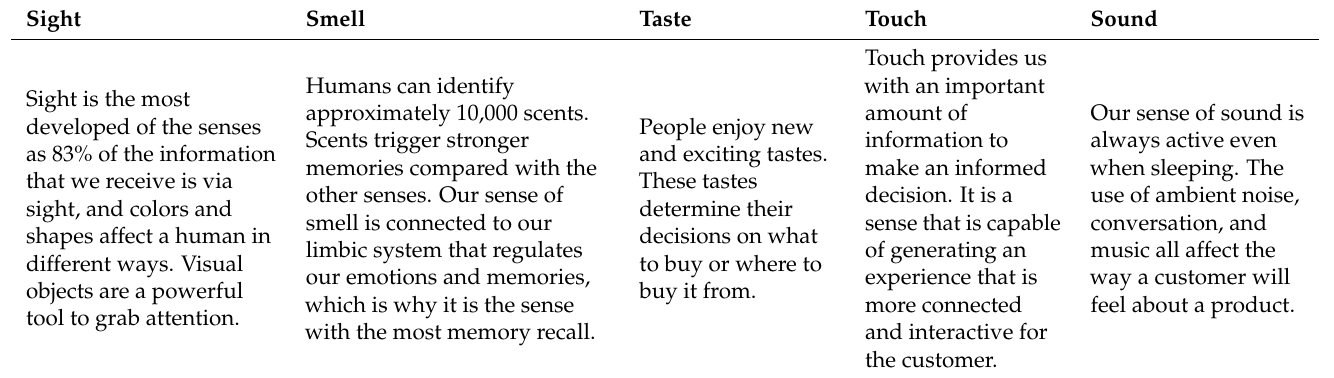
Table 6. Classification of the five senses